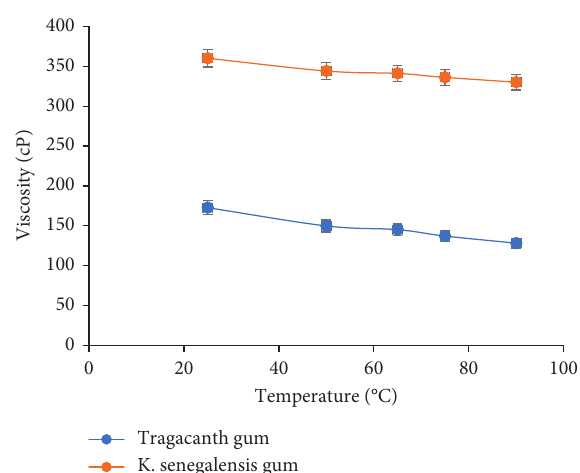
Figure 4: Plot of temperature against viscosity. The error bars represent standard deviations of 1 concentration in three sample runs ( n �